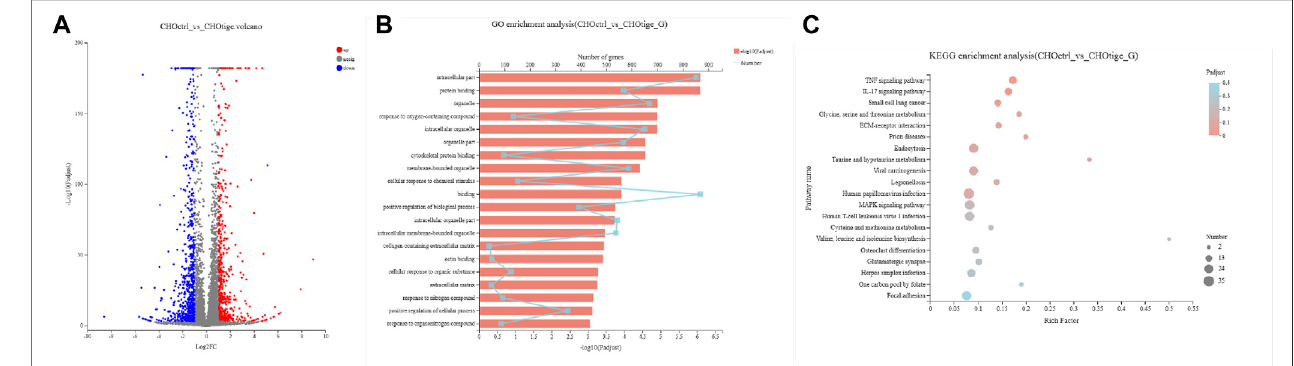
FIGURE 4 | The gene functional analysis of tigecycline by RNA-sequencing. (A) The volcano plot analysis of differentially expressed genes. Each point in the fi gure represents a speci fi c gene. Red points represent signi fi cantly up-regulated genes, blue points represent signi fi cantly down-regulated genes, and gray points represent non-signi fi cantlydifferentgenes. (B) TheGOfunctionalenrichmentanalysisofdifferentiallyexpressed genesbetweenCHOcellstreatedwithandwithouttigecycline. (C) The KEGG enrichment analysis of differentially expressed genes between CHO cells treated with and without tigecycline.